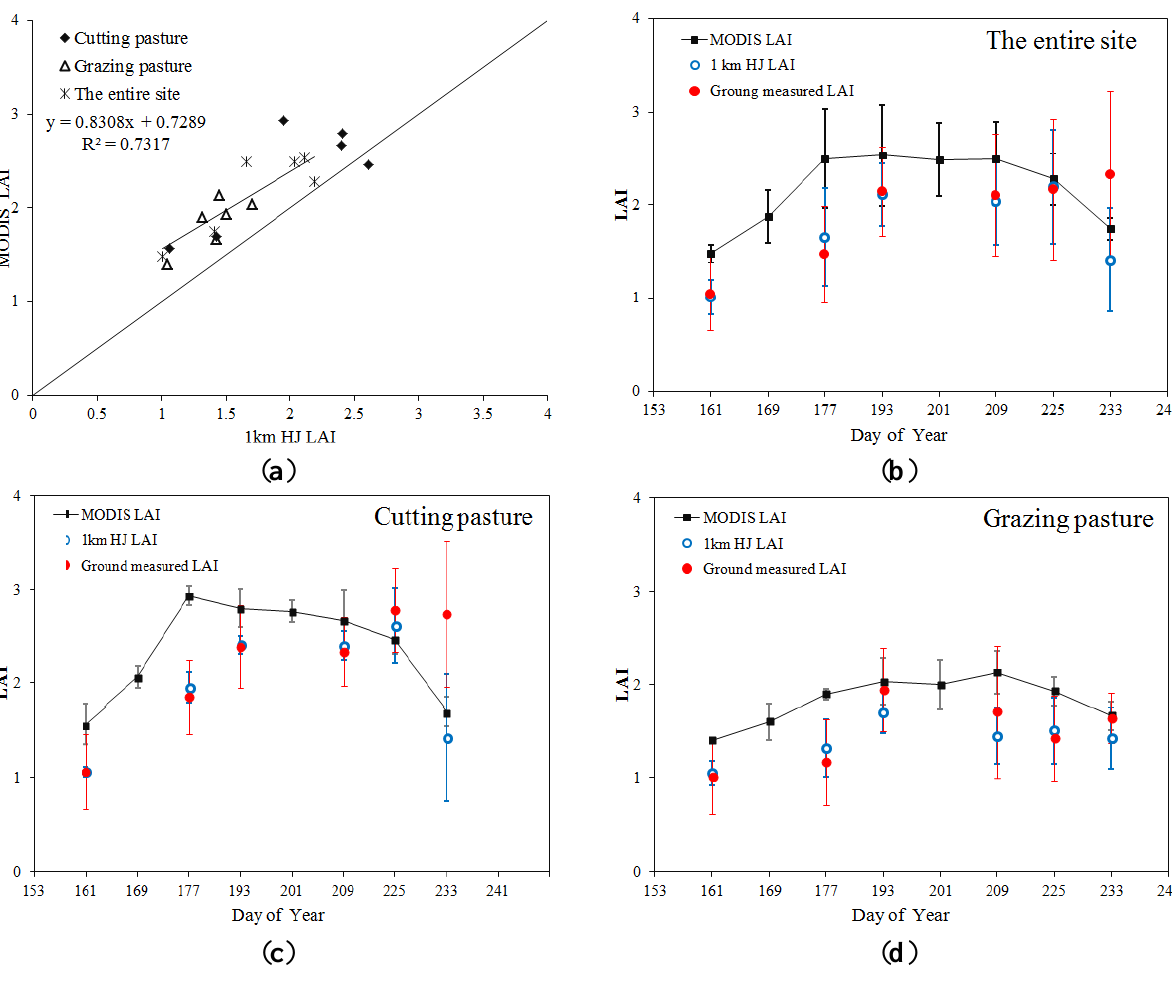
Figure 9. Patch-by-patch comparison between the MODIS and the aggregated HJ LAI values. The error bars indicate the standard deviations. ( a ) The scatter-plot of patch-by-patch comparison; ( b ) The entire site comparison; ( c ) Cutting pasture comparison; ( d ) Grazing pasture